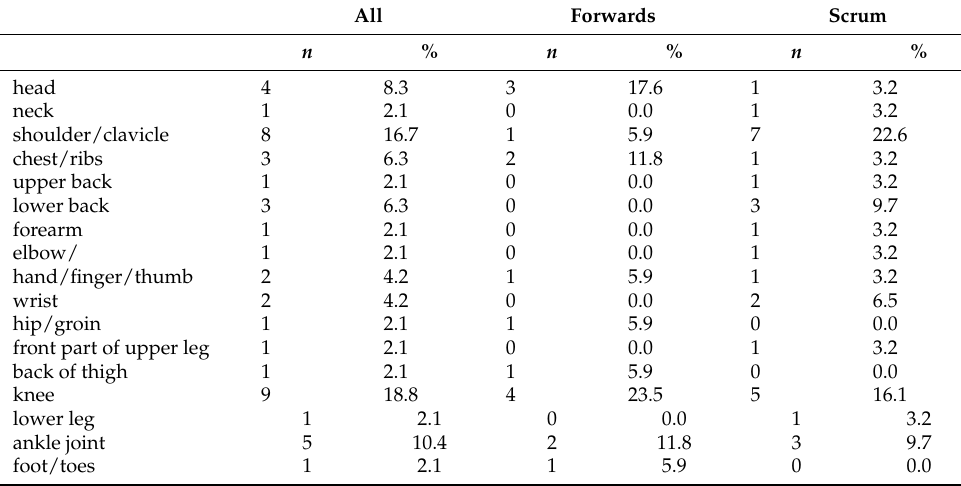
Table 2. Anatomical location of